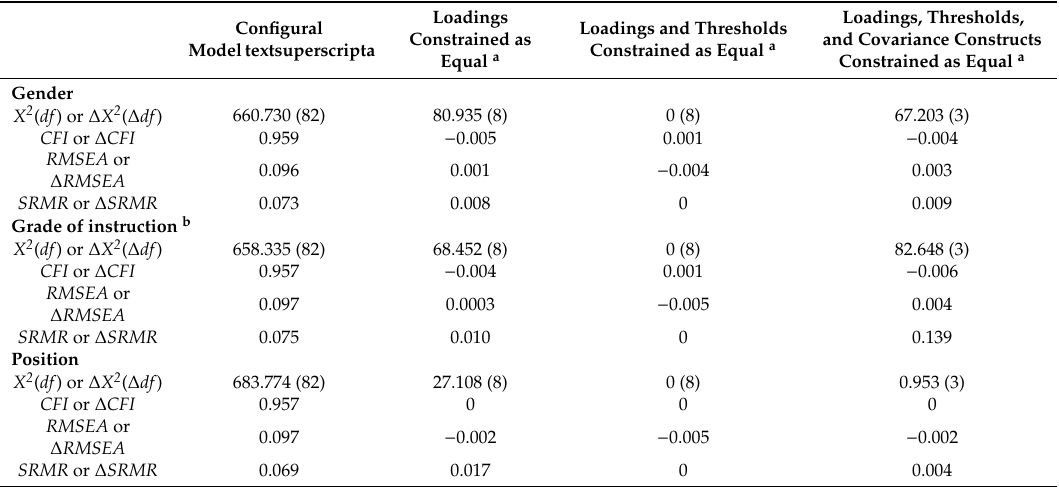
Figure 2. Bland–Altman plot for the di ff erences between CPNTT measures from the two test sessions against the mean of the two test sessions for each subject. The 95% limits of agreement are indicated by the dashed lines. Table 5. Measurement invariance across gender, grade of instruction and